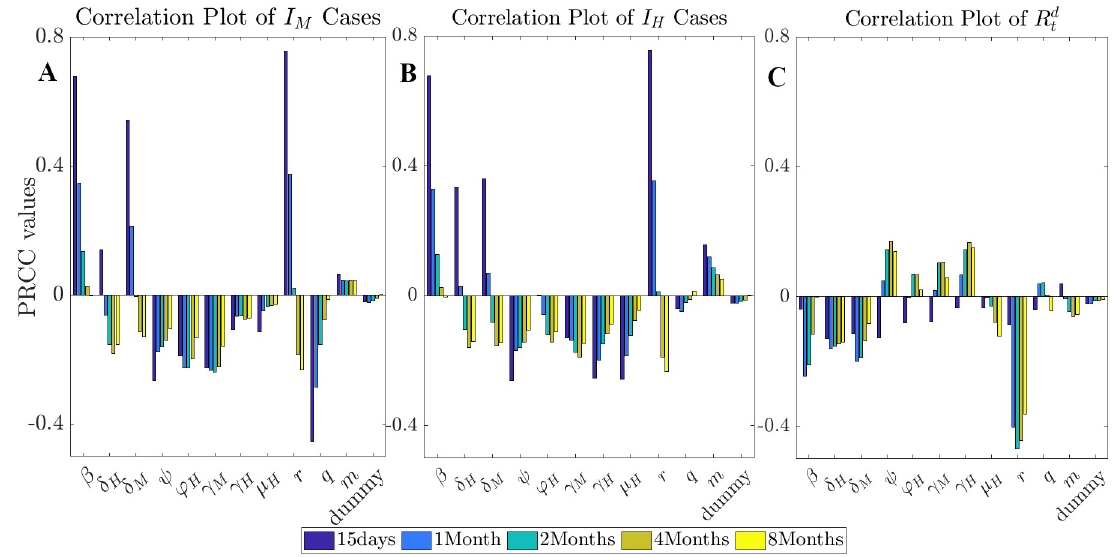
Fig 2. The PRCC of model parameters. Using 10,000 LHS samples for the period March 8, 2020, to March 5, 2021, for (A) the number of monitored cases, (B) hospitalized cases, and (C) the deterministic time-varying reproduction number ( R d analysis was performed via the LHS/PRCC